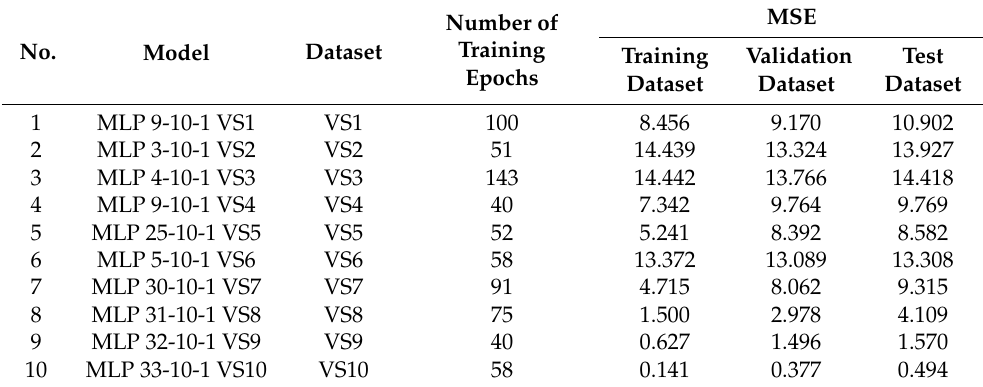
Table 5. Neural models for the prediction of the volatile solids content in the composted material.